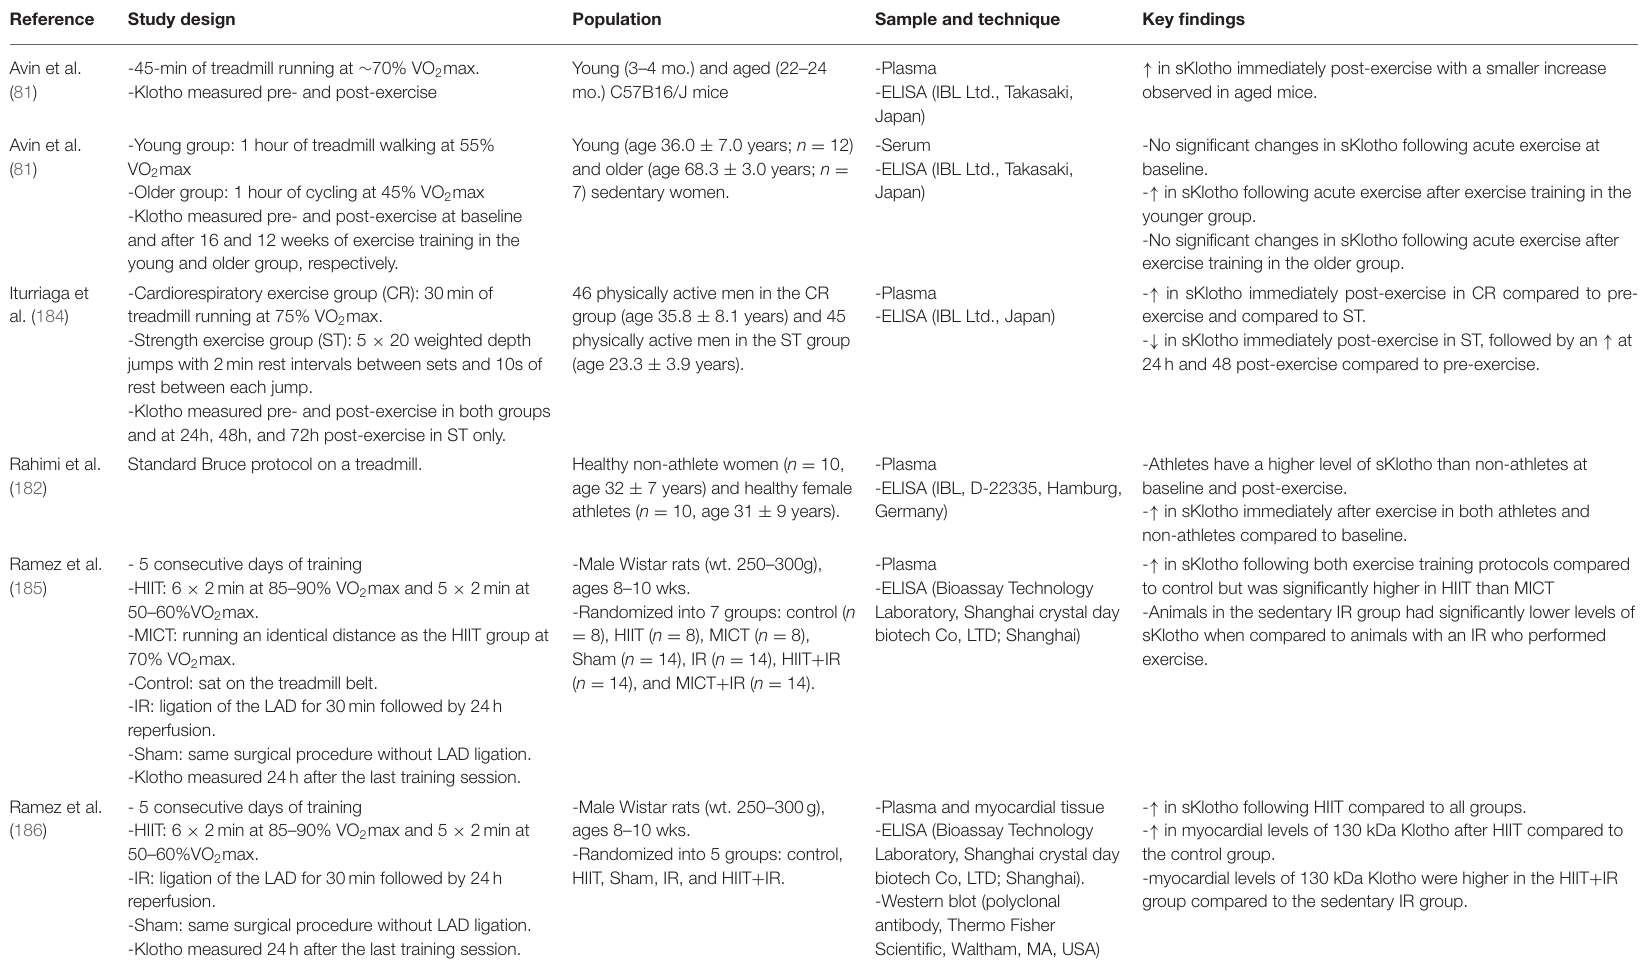
TABLE 2 | Effects of acute exercise on Klotho